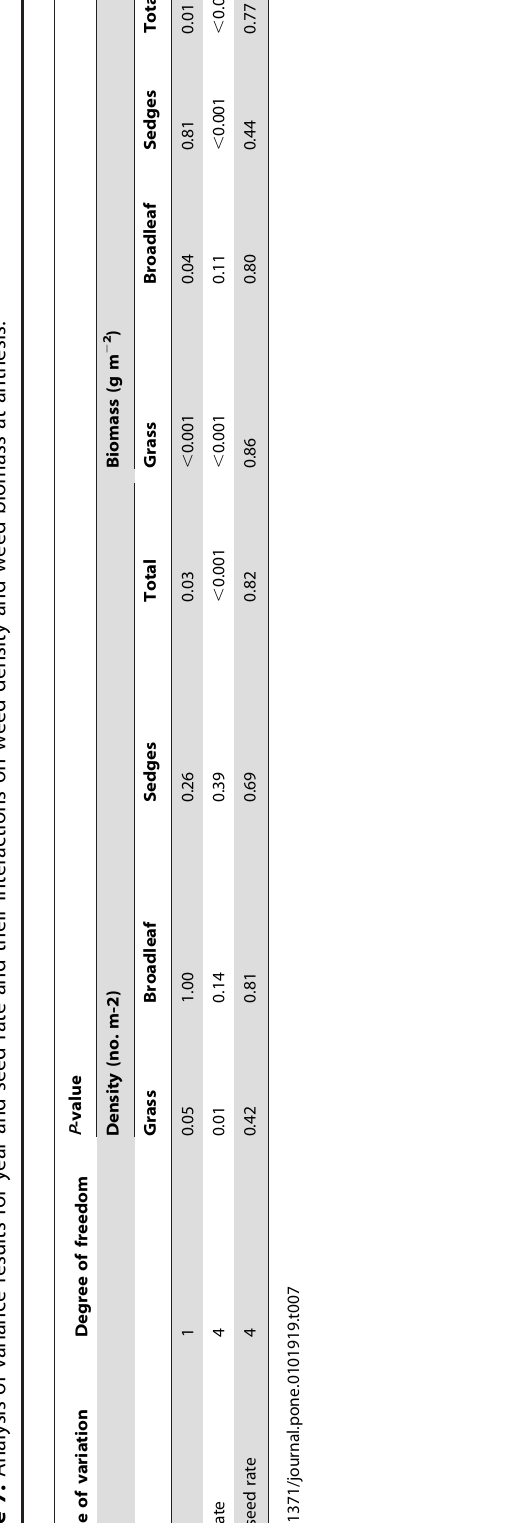
Figure 4. Relationship between rice seeding rate and weed biomass at crop anthesis in 2012 and 2013.